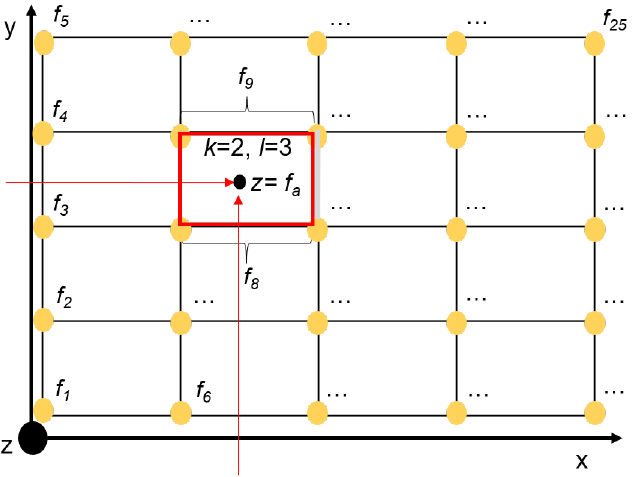
Figure 6. Exemplary determination of the approximative function value z = f a ( x , y ) with a 5 × 5 resolution.